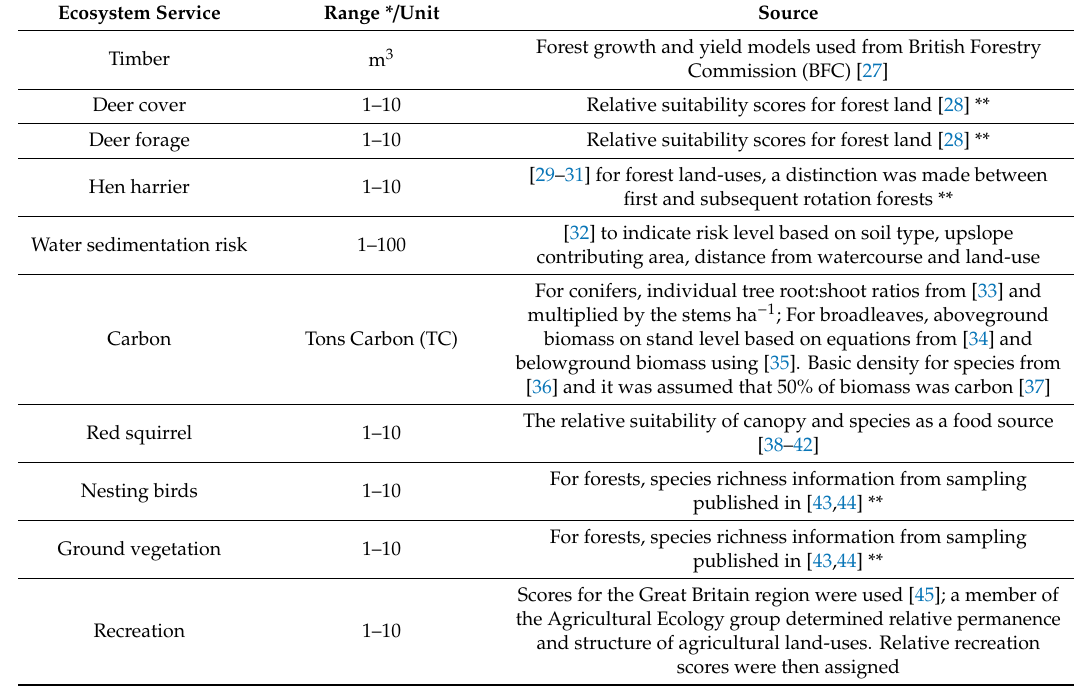
Table 2. A summary of the ecosystem services (ESs) in this model and original source of the methods used for their